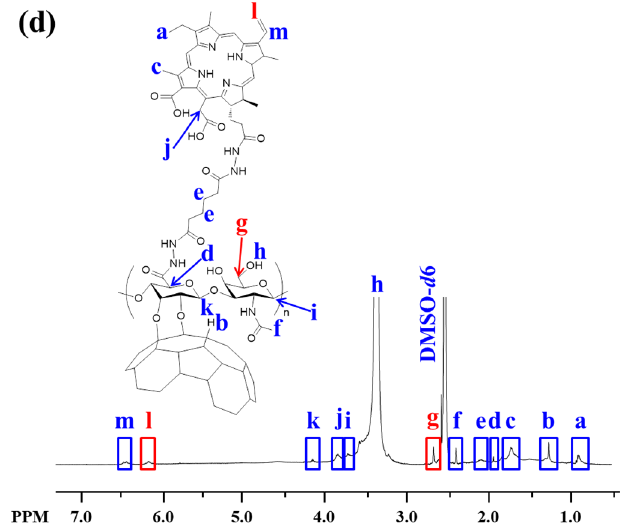
Figure 1. ( a ) Schematic illustration of dHA-Azo-Ce6. ( b ) Synthesis scheme of dHA-Azo-Ce6. ( c ) 1 H-NMR peaks of dHA-Azo-Ce6. ( d ) 1 H-NMR peaks of dHA-Ce6.